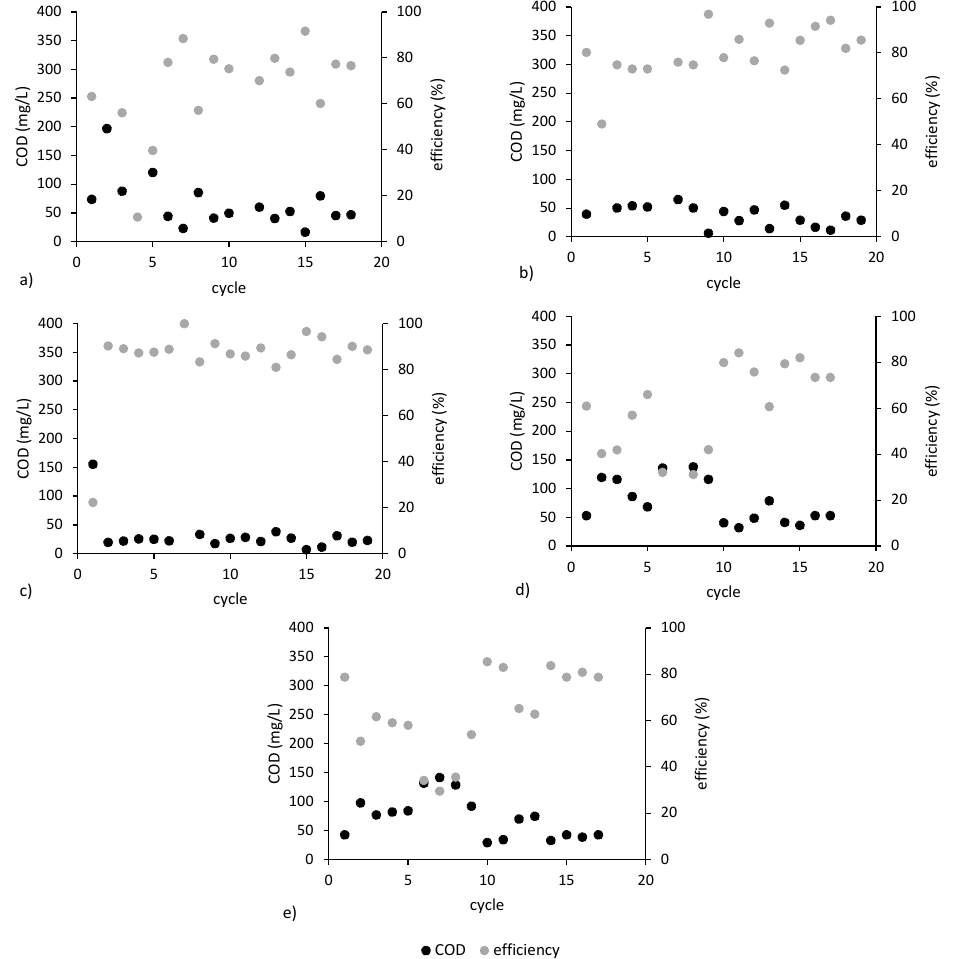
Figure 4. COD concentration in the effluent and COD removal efficiency in ( a ) MFC control , ( b ) MFC 0.05Fe , ( c ) MFC 0.1Fe , ( d ) MFC 0.2Fe , and ( e ) MFC 0.4Fe .